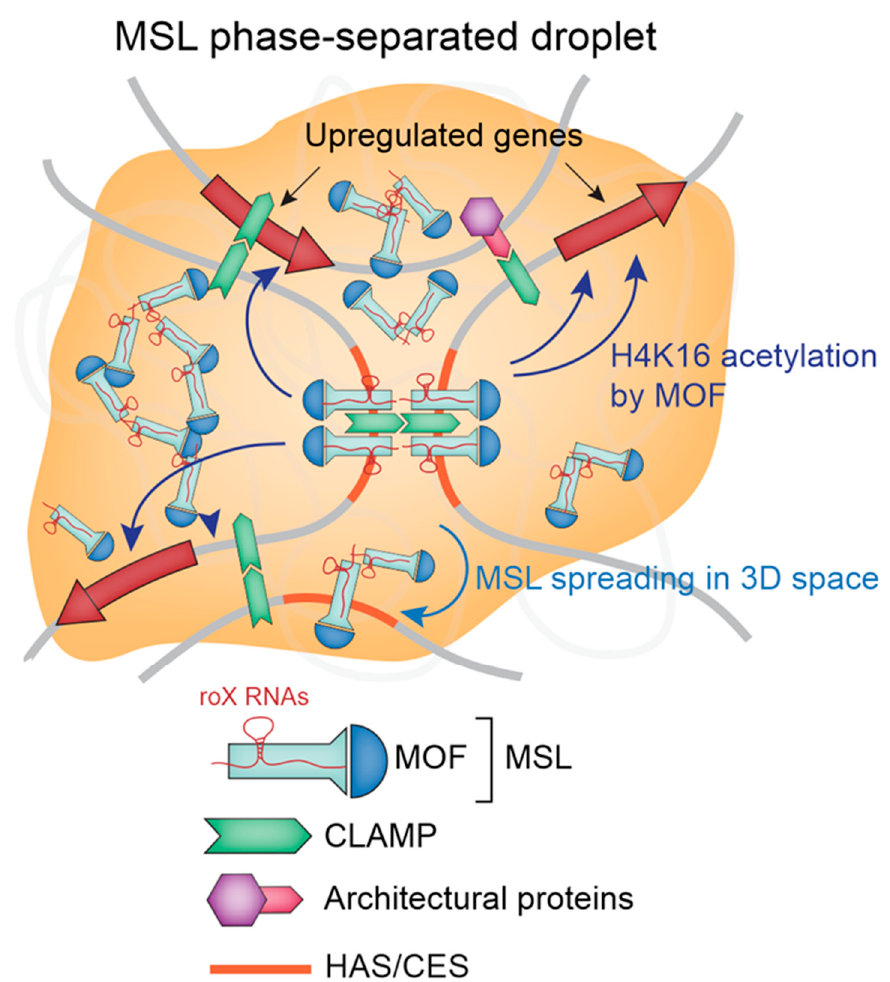
Figure 1. Schematic illustrating mechanisms involved in canonical DC. See text for